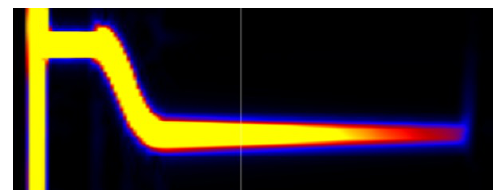
Fig. 20. Group III’s spectrogram showing a legato slide between C and G. Yellow shows the